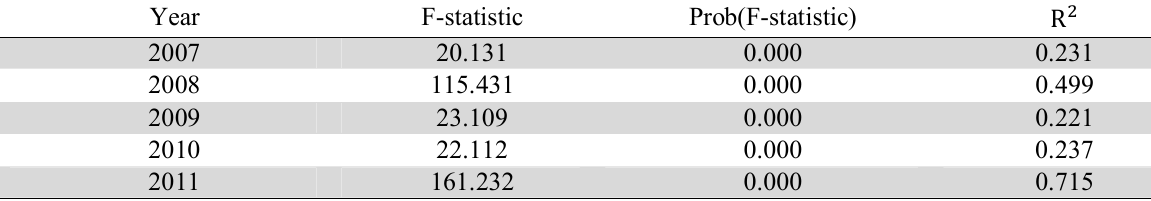
Results of the first hypothesis (H1) significance tests per year